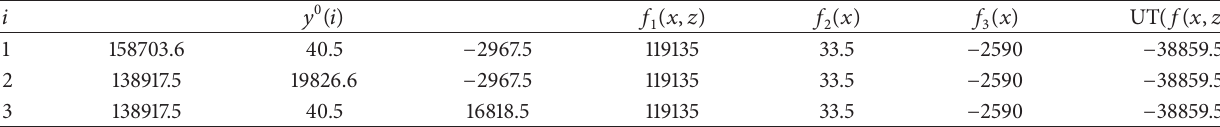
Table 3: The efficient points obtained at the first iteration according to the perturbed reference